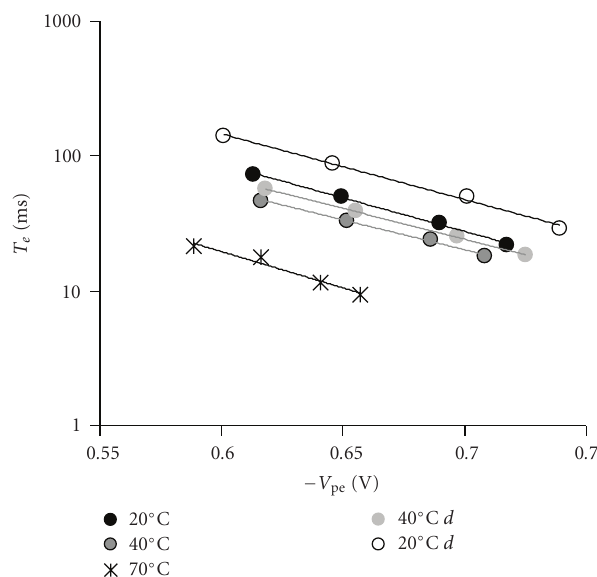
Figure 12: Electron lifetimes in the TiO 2 film, as a function of photoelectrode voltage, at di ff erent temperatures; second set of EIS measurements. Letter “ d ” after the temperature value indicates the downward sweep of the temperature